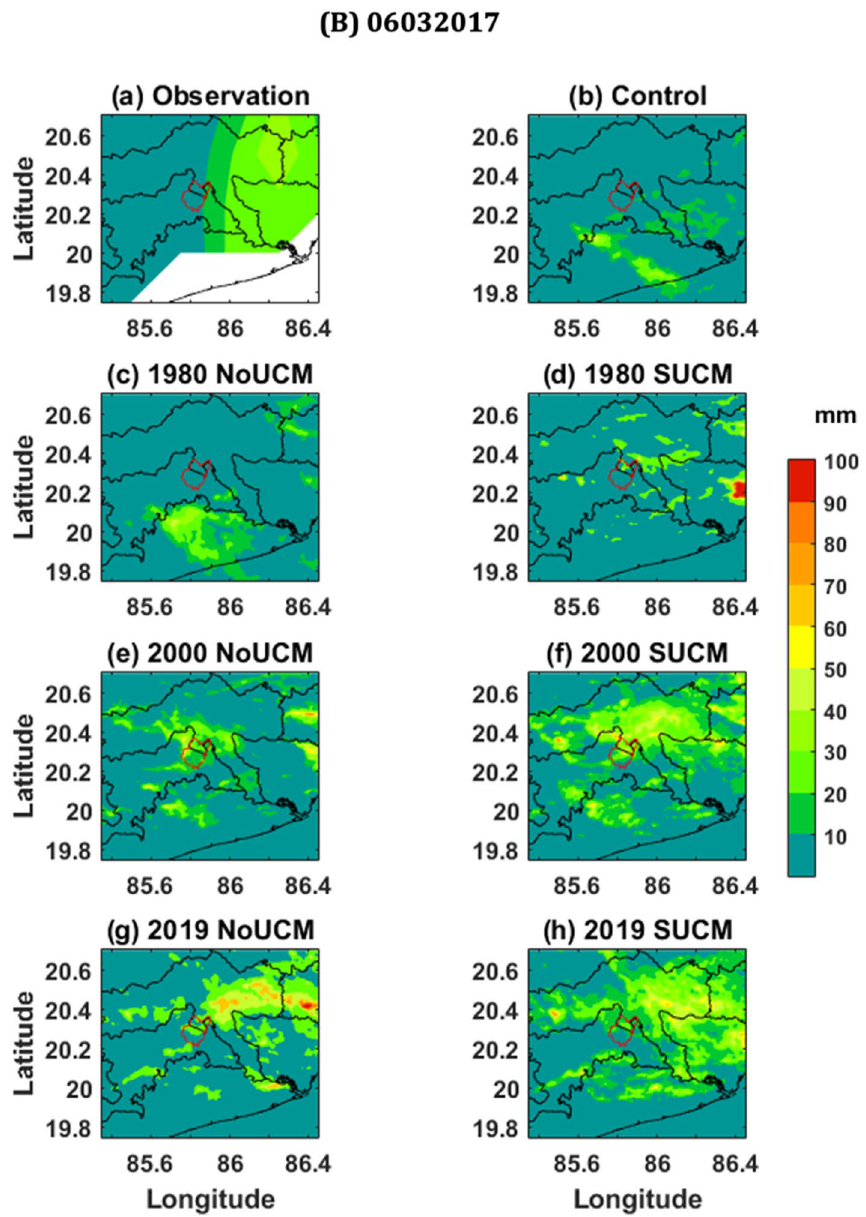
Heidke skill score (HSS) is a measure of skill in